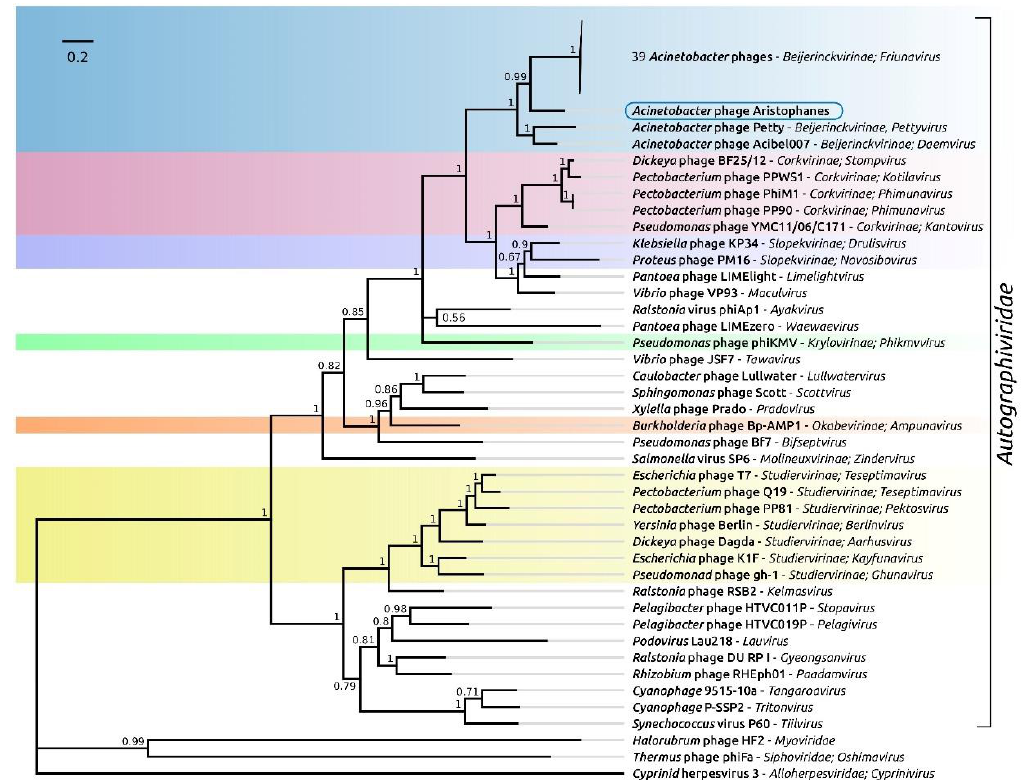
Figure 5. Phylogenetic tree obtained with MrBayes, based on amino acid sequences of terminase large subunit including representatives of all genera of the subfamily Beijerinckvirinae of the family Autographiviridae . Taxonomic classification is shown to the right of the organism name. Bayesian posterior probabilities are indicated above their branch. The scale bar shows 0.2 estimated substitutions per site and the tree was rooted to Cyprinid herpesvirus 3; 2,100,000 generations sampled every 200 generations, with burn-in length of 100,000 and an average standard deviation of split frequencies of 0.010.